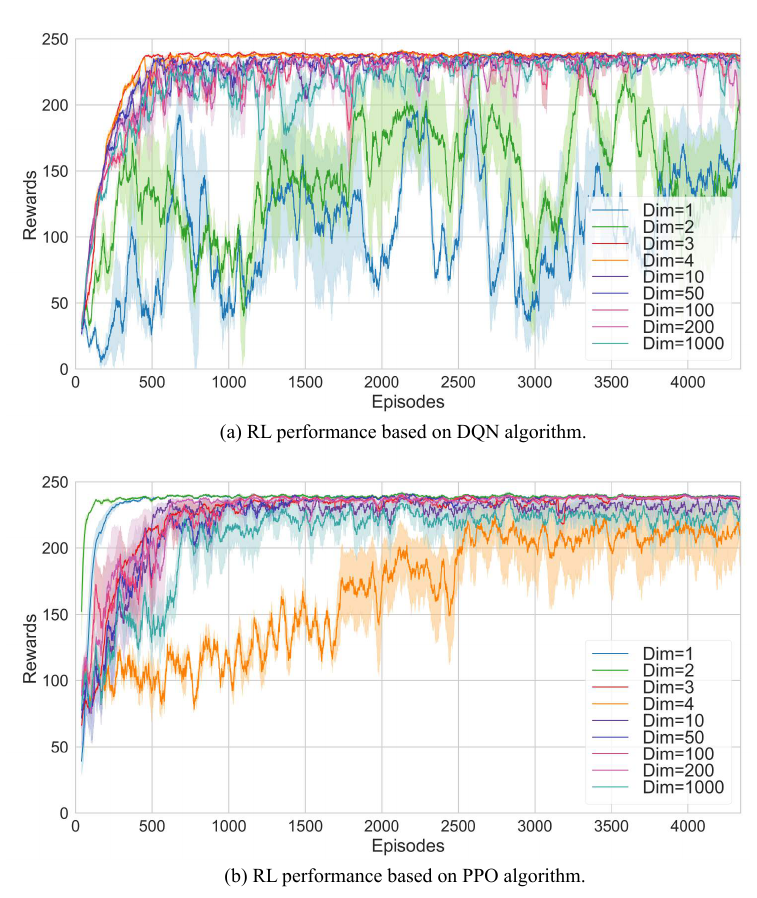
Figure 7. Performance (mean and standard error for 5 runs) of DQN and PPO algorithms with state representations learned from different embedded dimension in mobile robot 1D navigation